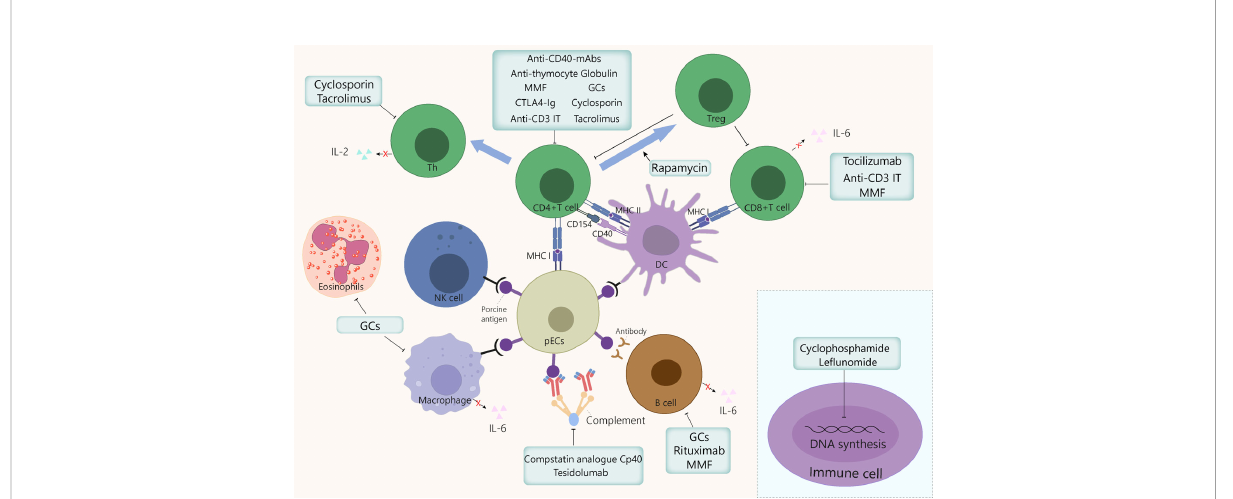
FIGURE 3 Mechanism of action of the immunosuppressants commonly used in xenotransplantation. GCs exert anti-in fl ammatory and immunosuppressive effects by inhibiting macrophages, eosinophils, T cells, and to a lesser extent, B cells, by binding to GC receptors in cytoplasm. Cyclosporin binds to cyclophilin, then this drug-immunophilin complex binds to calcineurin, which subsequently prevents Th cell activation and IL-2 production, which eventually inhibits T cell clonal proliferation. Tacrolimus inhibits T cells proliferation by binding to FKBP, which inhibits several transcription factors involved in the production of proin fl ammatory cytokines. Cyclophosphamide blocks DNA alkylation in various cell types, leading to programmed cell death induction and preventing cell division. Le fl unomide inhibits the synthesis of pyrimidines, thus arresting cell cycle in S phase. Mycophenolate mofetil prevents T and B cell proliferation by speci fi cally inhibiting a purine pathway required for lymphocyte division. Polyclonal anti-thymocyte globulins are mainly directed against T cells. However, other immune cells sharing common surface antigens with T cells can also be affected to a lesser extent. Monoclonal antibodies target speci fi c cytokine pathways (e.g., IL-6R a ) or cell surface markers, such as CD3, for anti- C3 IT, or CD20, for rituximab. The IL-6 receptor inhibitor tocilizumab reduces systemic in fl ammation and inhibits of CD8+ T cell and B cell differentiation. Anti-CD3 IT can deplete CD3+ T cells transiently and reduces the number of T cells in circulation and in lymph nodes. Rituximab is a B cell-depleting drug that targets CD20. Rapamycin exerts immunosuppressive and anti-proliferative effects of T cells by inhibiting the activation of S6K1 and PI3 kinase signalling. CTLA-4Ig and anti-CD40mAb target the costimulatory pathways CD80/86:CD28 and CD154:CD40, respectively, thereby dampening T cell activation. The compstatin analogue Cp40 and Tesidolumab inhibits complement C3 and C5 respectively,